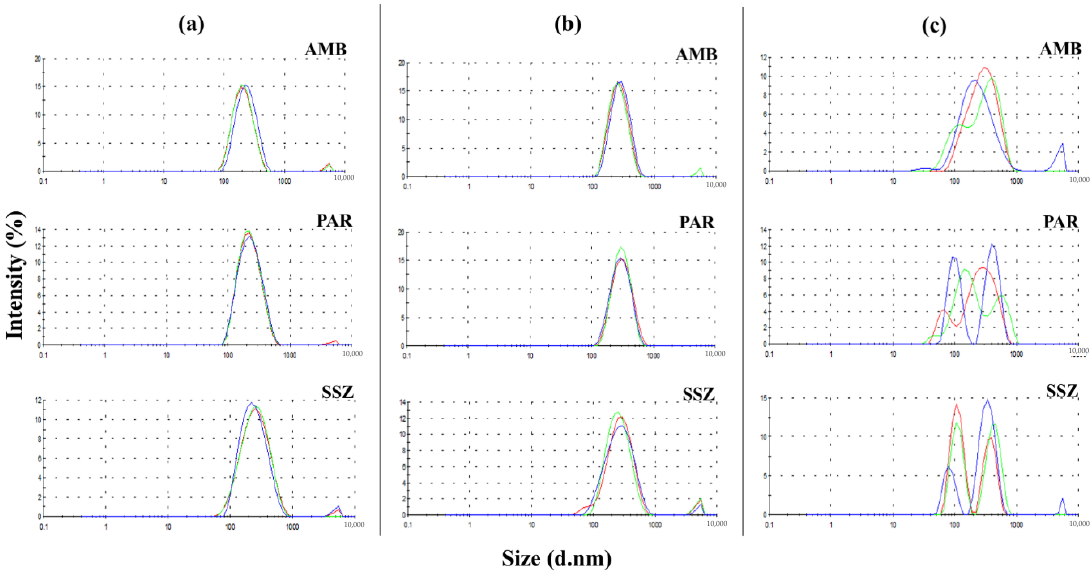
Figure 3. DLS (dynamic light scattering) size distribution by intensity graphs for ( a ) freshly prepared, ( b ) stored (24 months), and ( c ) lyophilized AMB-SLNs, PAR-SLNs, and SSZ-SLNs ( n =